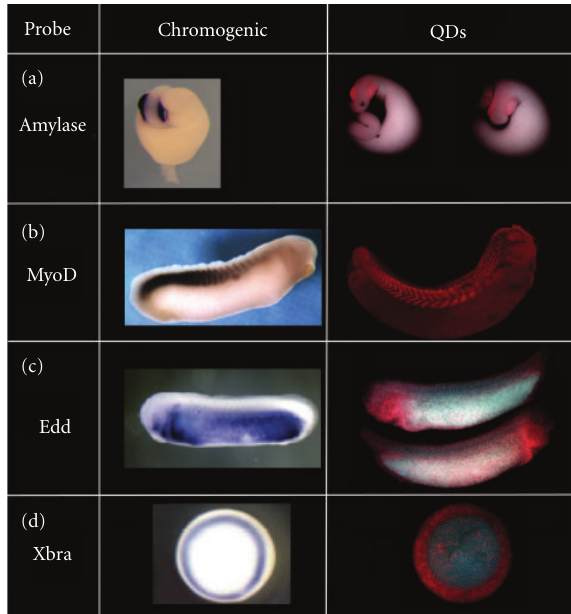
Figure 3: In situ hybridization using QDs compares favorably with chromogenic in situ hybridization staining for a number of well-characterized mRNAs. (a) 705nmQD-streptavidin staining for amylase on dissected Xenopus guts, using a biotinylated amylase probe, is compared to the staining obtained by chromogenic reaction (left). The staining using QDs is identical to that using a chromogenic reaction and restricted to the pancreas, where amylase mRNA is expressed. It is worth noting that the pancreas, a morphologically identifiable organ, is extremely autofluorescent making detection of fluorescent staining di ffi cult. (b) Comparison of the QD and chromogenic staining for MyoD a muscle marker (using a FITC-labeled probe). The 655 nmQD anti-FITC and the chromogenic staining are similar, but the QD staining gives much better resolution of the posterior somites. (c) Comparison of QD versus chromogenic staining for the Edd transcript, an endodermal marker expressed through the tadpoles gut at varying levels (using a Biotin-labeled probe). The staining using a chromogenic protocol is significantly stronger in this case and the 705 nmQD-Streptavidin seems restricted to the high expression regions. Careful observation reveals that the staining is present throughout the gut region but is masked by the intense autofluorescence of the gut. (d) Comparison of the QD staining versus the chromogenic staining for Xbra, a widely used mesodermal marker (using a Biotin-labeled probe). The marker is known to label the mesodermal belt at gastrula stages; both the chromogenic, as well as the QD-streptavidin protocols result in the same staining pattern consistent with the mesodermal